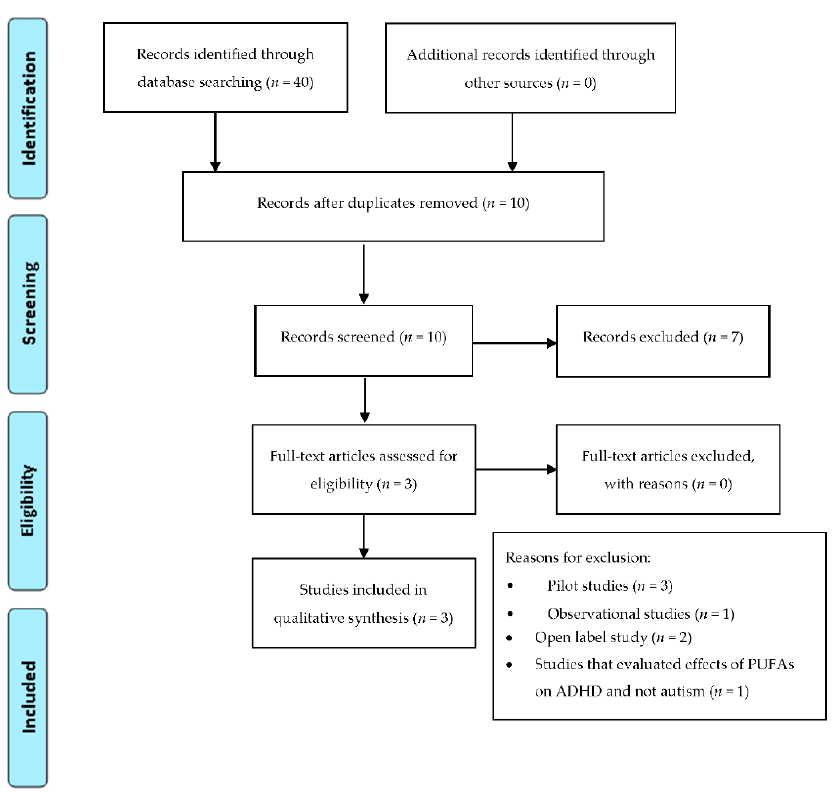
Figure 2. PRISMA diagram: ω -3 PUFAs supplementation in ADHD.